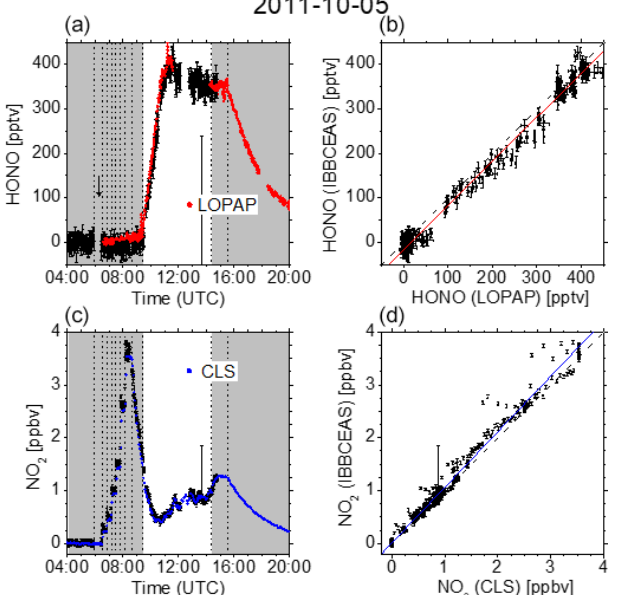
Figure 4. (a, c) Time-dependent HONO and NO 2 mixing ratios measured at SAPHIR on 6 October 2011. Dashed vertical lines in- dicate changes in the chamber conditions according to the experi- mental protocol: overnight flushing stopped (06:04UTC), humidi- fication started (10:47UTC), humidification stopped (11:29UTC), roof opened (12:18UTC), and roof closed (16:24UTC). IBBCEAS data taken in the near-UV region of the spectrum (352–386nm) are compared to LOPAP (red) and CLS (blue) data. The vertical black arrow indicates the time when I 0 was measured (generally for 10min). (b, d) Correlation plots of two instruments being compared against IBBCEAS. The dashed line represents the identity, and the coloured solid lines are linear regressions to the data. Results are listed in Table